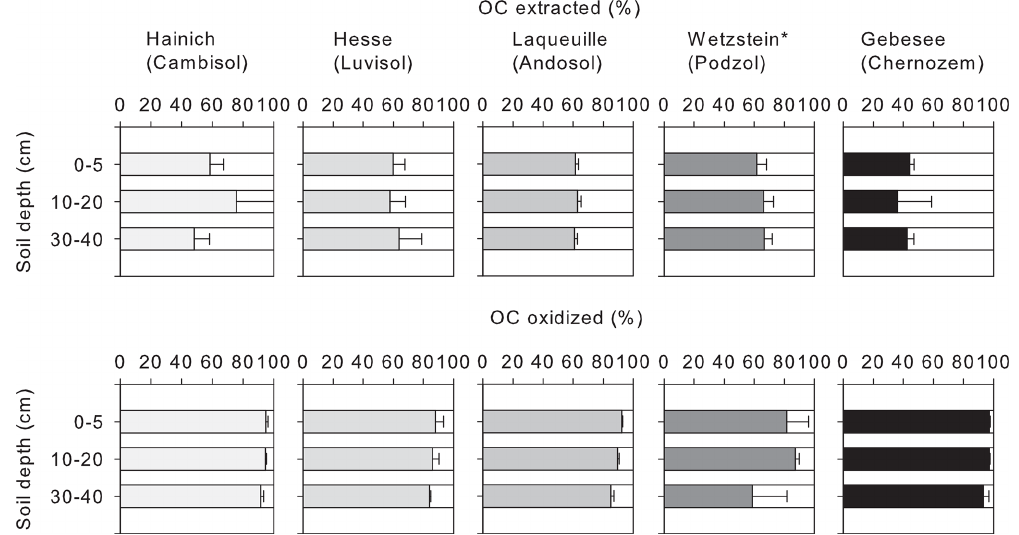
Figure 1. Proportion of OC extractable with NaF–NaOH or oxidized with heated H 2 O 2 from the mineral-associated OC fractions of soil samples from five different sites (Hainich, Hesse, Laqueuille, Wetzstein, and Gebesee) and three soil depths (0–5, 10–20, and 30–40cm); for Wetzstein the studied soil depths were 0–10, 10–30, and 30–50cm. “*” denotes that different soil depths were studied at the Wetzstein site.